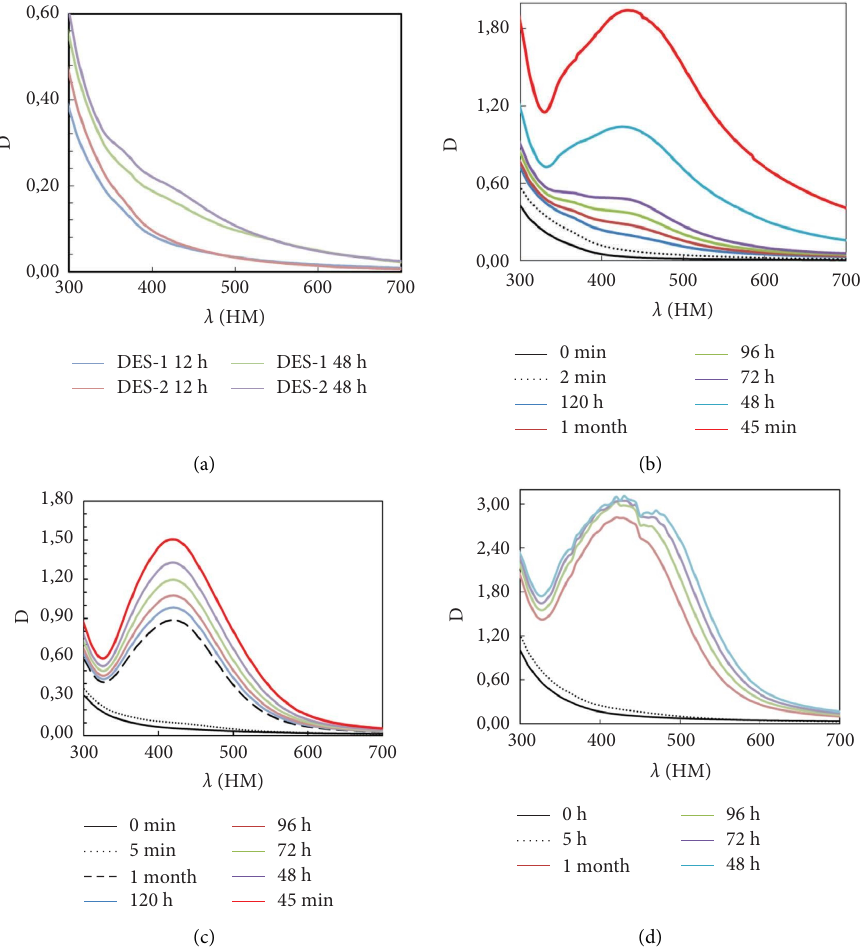
Figure 6: UV-visible spectra of AgNO 3 with only DESs (a) in water and “green” synthesized silver nanoparticles with grape pomace extract obtained by P-GPE (b), B-GPE (c), and W-GPE